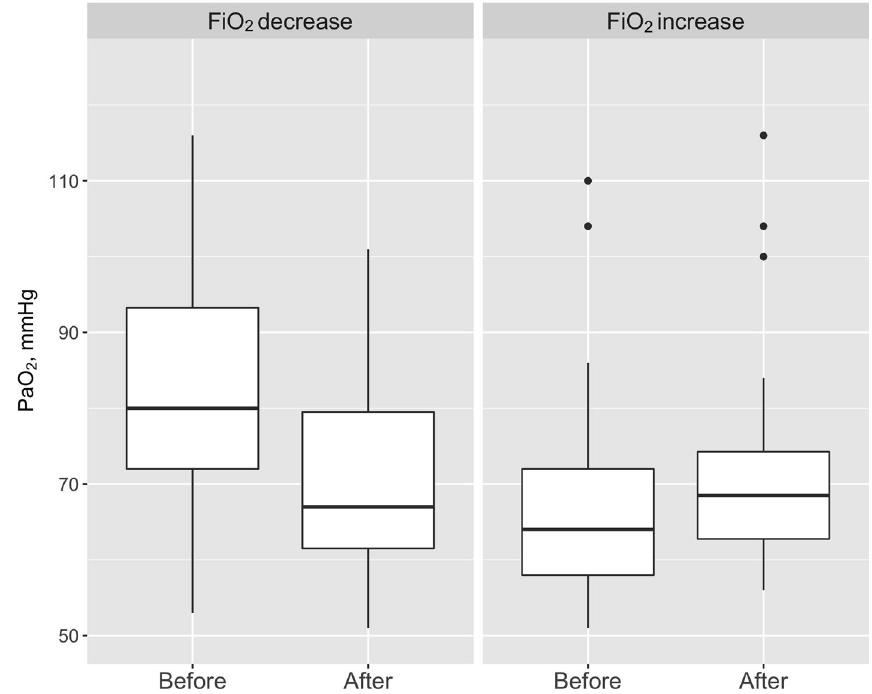
Fig. 3 Box plot representation of arterial blood oxygen tension before and after changes in fractional inspired oxygen. FiO